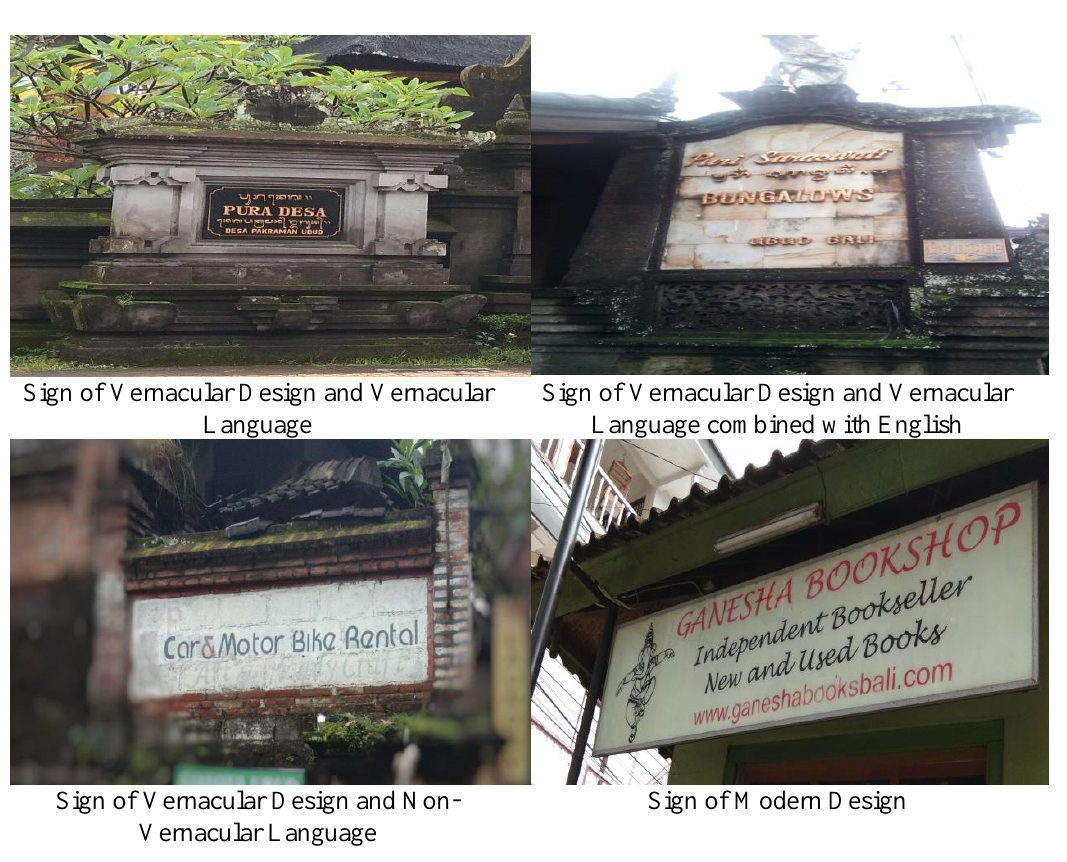
Fig. 4: Visual Design and Language Use of Outdoor Signs in